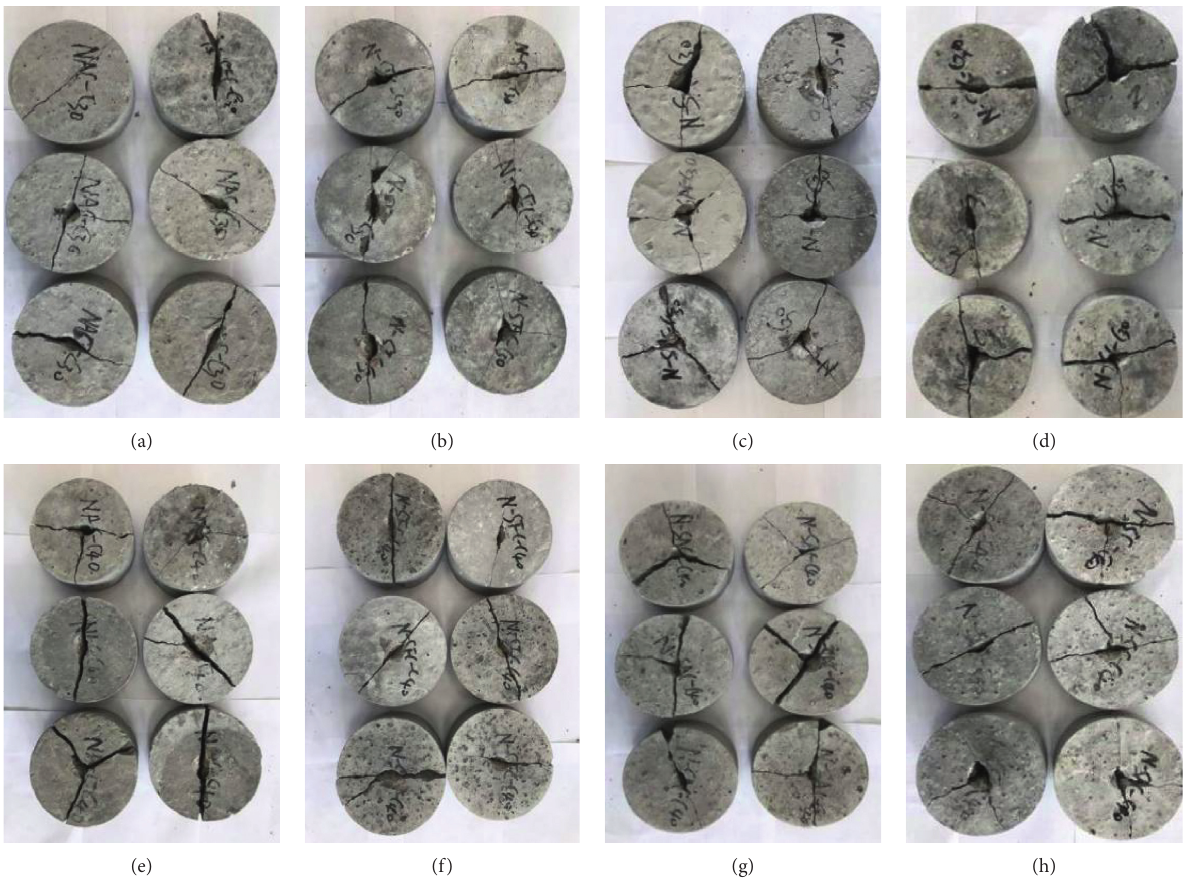
Figure 10: Final cracking state of concrete. (a) NAC-C30. (b) N-SFC-C30. (c) N-SAC-C30. (d) N-SC-C30. (e) NAC-C40. (f) N-SFC-C40. (g) N-SAC-C40. (h) N-SC-C40.